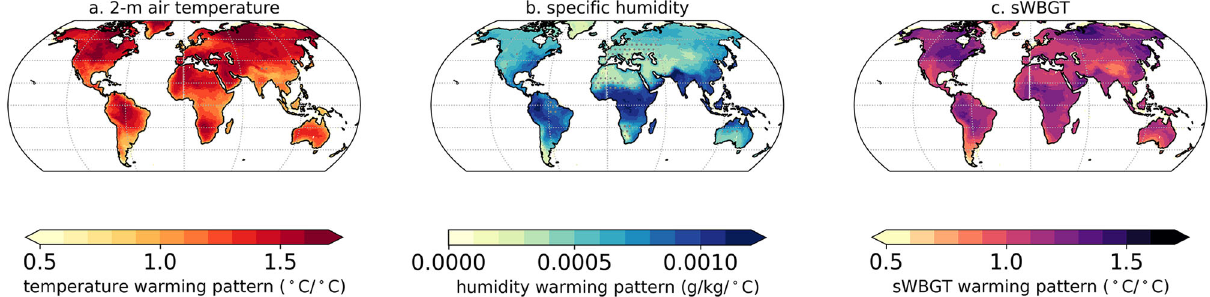
Fig. 2 Warming patterns of temperature, humidity, and sWBGT in CMIP6 models. Local warming patterns (local change per degree of global warming) for the annual 75th percentile of a daily mean 2-m surface air temperature, b daily near-surface speci fi c humidity, and c daily simpli fi ed Wet Bulb Globe Temperatures (sWBGT) in Coupled Modeling Intercomparison Project, Phase 6 (CMIP6) 1%CO 2 simulations ( n = 21). Maps show multi-model median values for each grid point, with stippling on maps where there is disagreement in the magnitude of local change (coef fi cient of variation >0.35; “ Methods ” ).